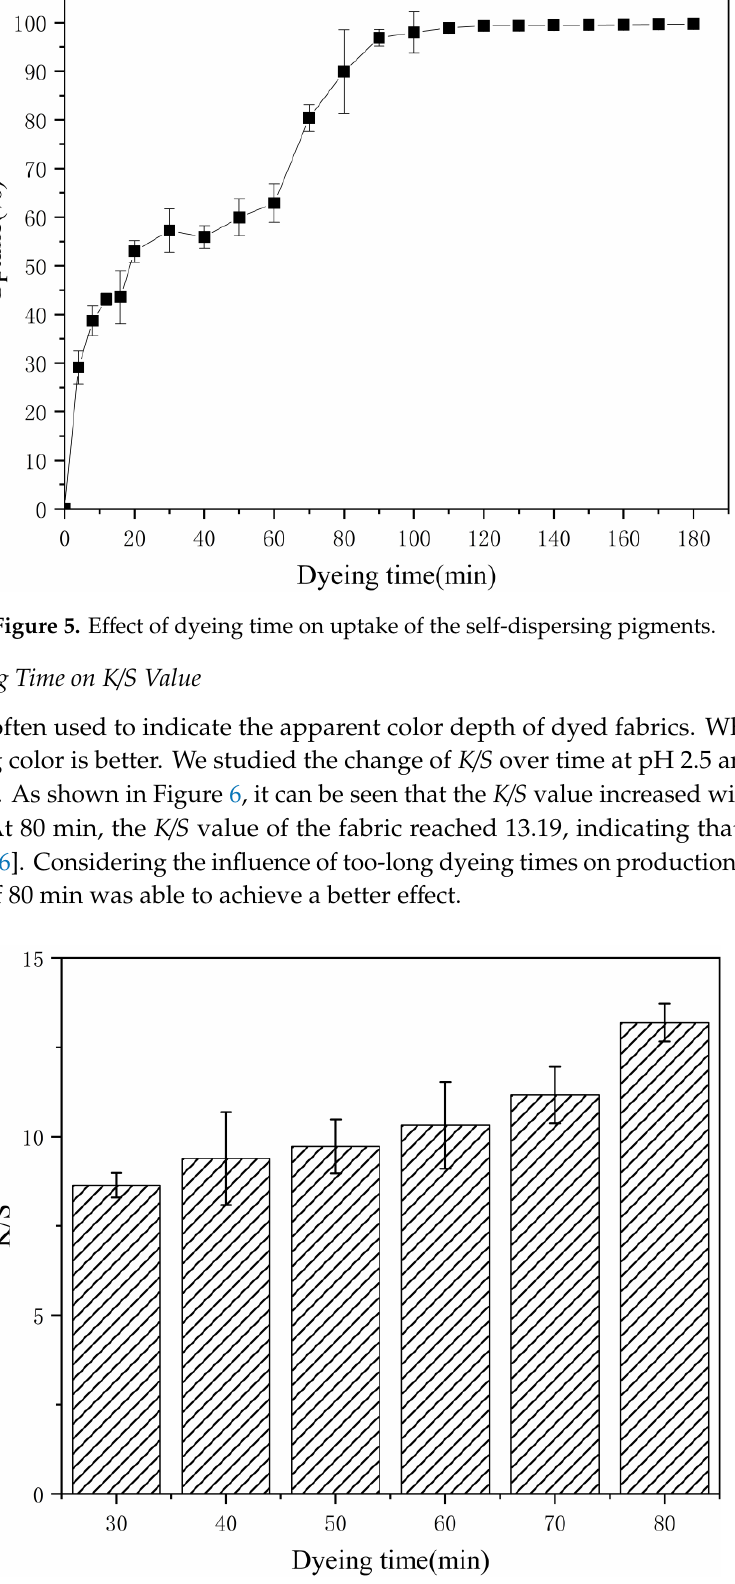
Figure 6. E ff ect of dyeing time on K / S Figure 6. Effect of dyeing time on K/S value. Figure 6. Effect of dyeing time on K/S value.